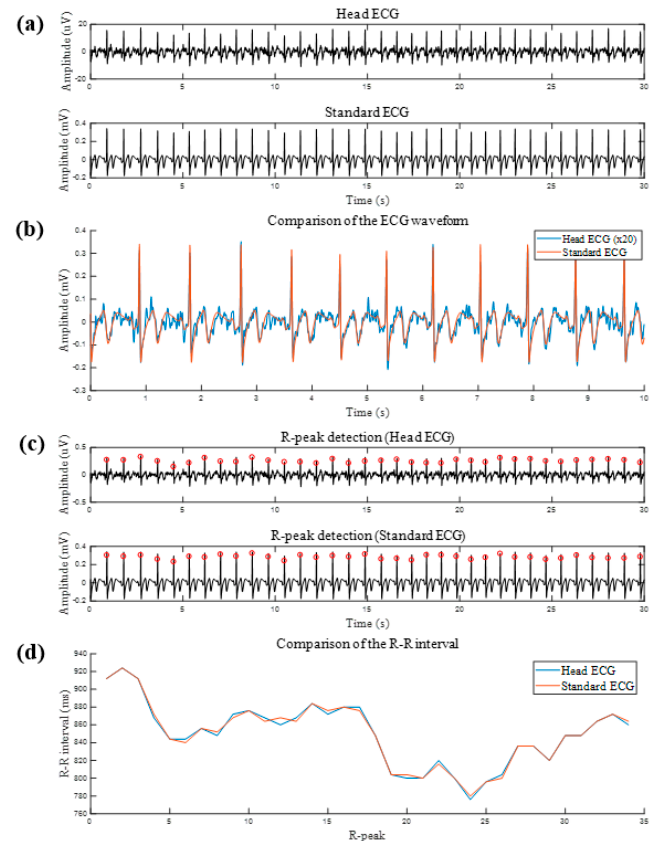
Figure 9. Comparison of the head ECG and the standard ECG. ( a ) Raw waveform of the head ECG and standard ECG. ( b ) Overlap of the head ECG (amplified 20 times) and the standard ECG. ( c ) R-peak detection of the head ECG and the standard ECG. ( d ) Comparison of the R–R interval from the head ECG and standard ECG.